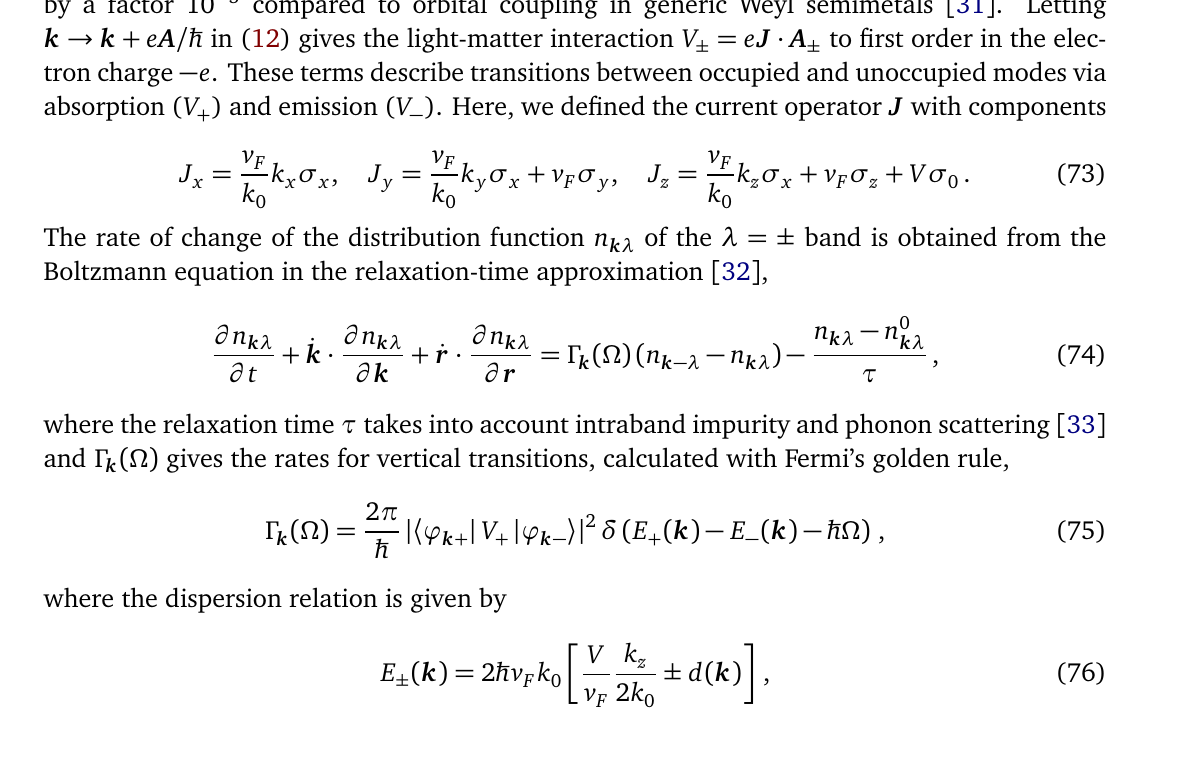
of the conduction band, integrated over k + ) 2 / ħ h for k = 0 (left) and at k A F y 0 denotes an electron (hole) pocket z = 0. The occupied states with negative F